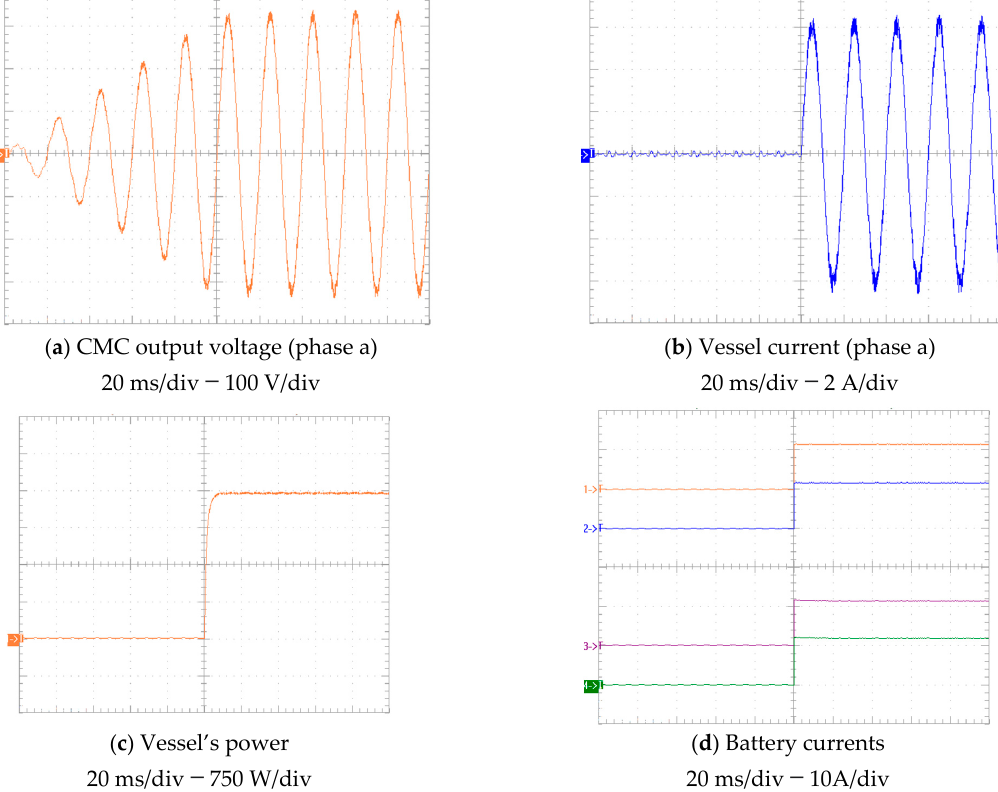
Figure 28. Mode 3 (from batteries to vessel) experimental